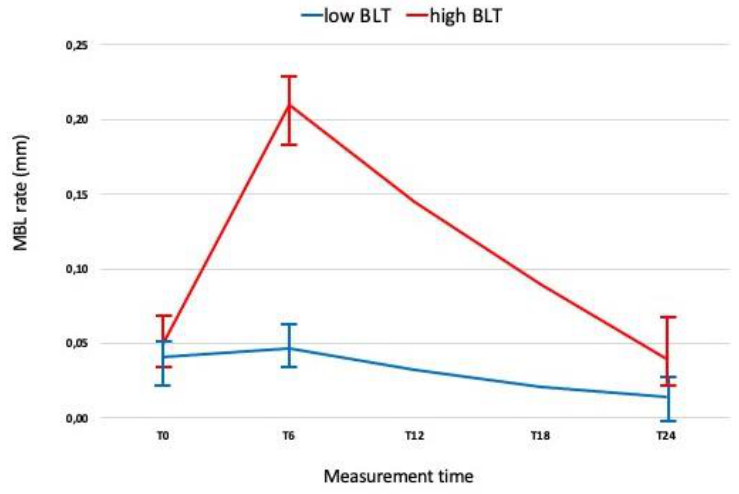
Figure 3. Marginal bone loss rates as a function of time. Healing time (T0 = 6 months from surgery — restoration delivery); T6 and T24 were measured at 6 and 24 months after functional loading.